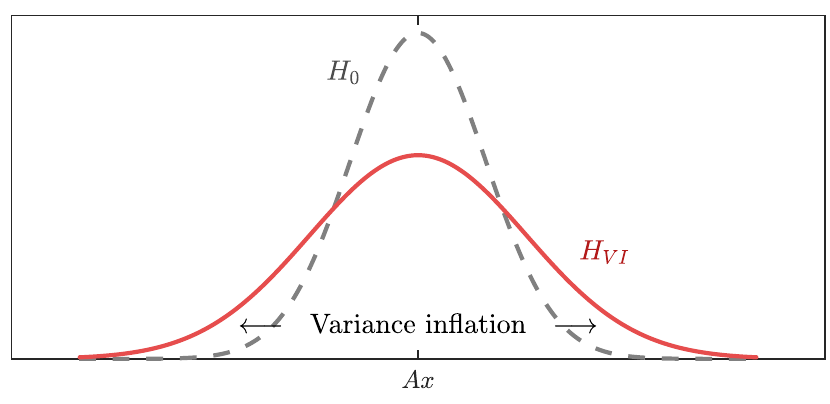
Figure 2. Schematic representation of the VI approach. The null model H 0 is depicted by a dashed grey line and the alternative model H VI is shown as solid red